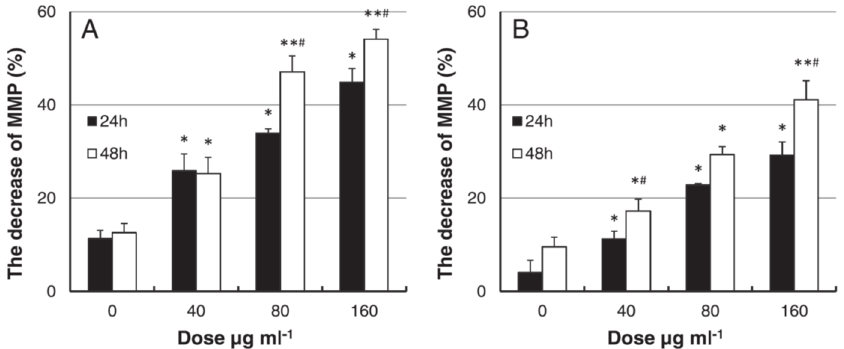
Figure 21. Dose-and time-dependent MMP reduction of HepG2 cells exposed to AgNPs in ( A ) deionized water and ( B ) cell culture medium. Data are expressed as means ± SD. There was significant difference between the treated and control groups (* p < 0.05; ** p < 0.01), and between the 24- and 48-h groups (# p < 0.05). Reproduced from [194] with permission of Wiley.